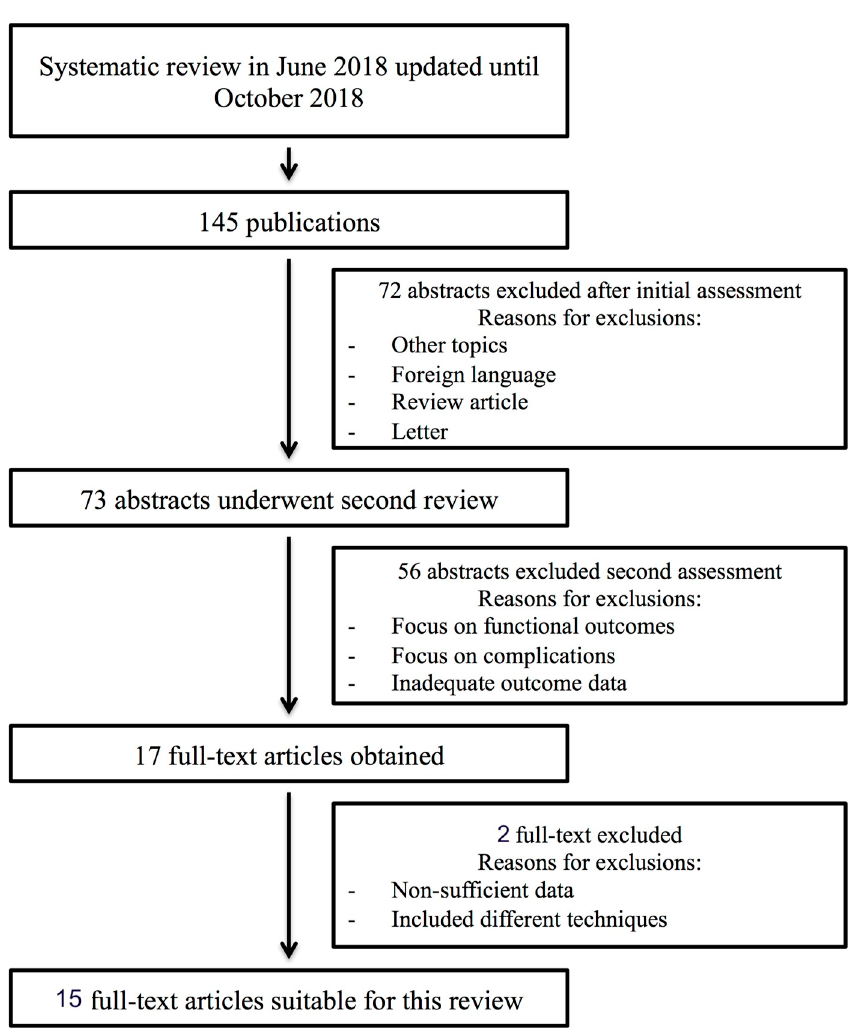
Figure 1. Flow chart for the inclusion of studies.